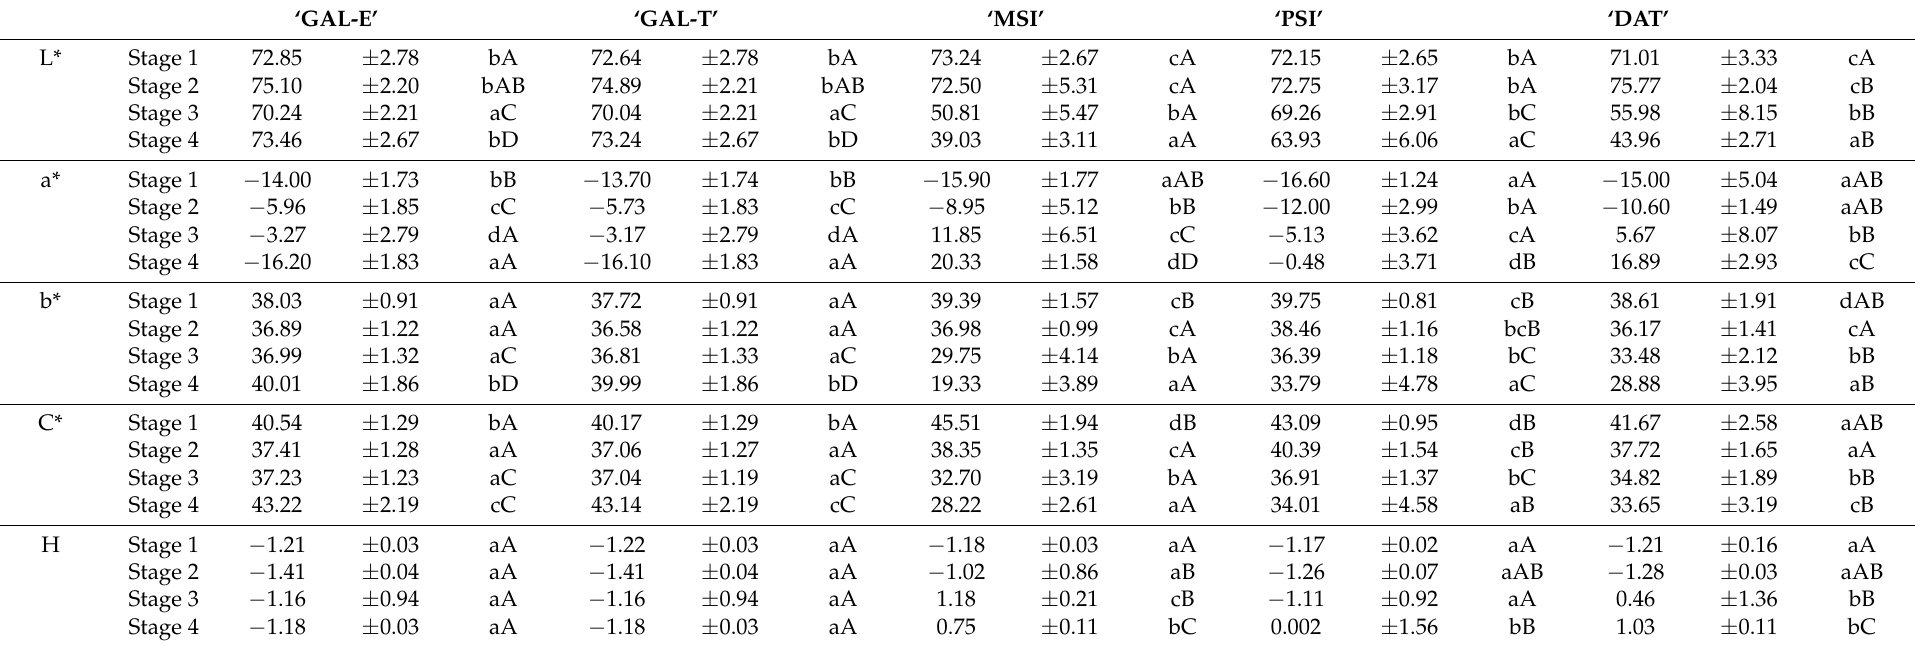
Table 1. Color parameters of five Spanish cultivars as affected by cultivar and stage of